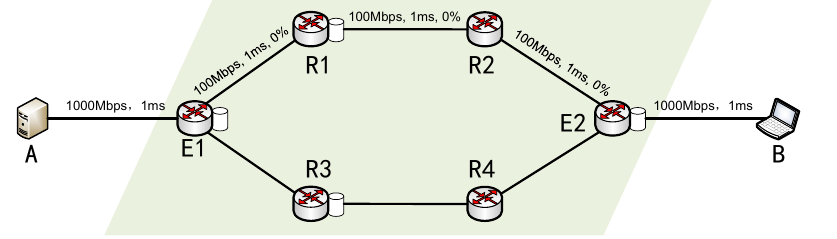
Figure 4. Simulation topology 1.